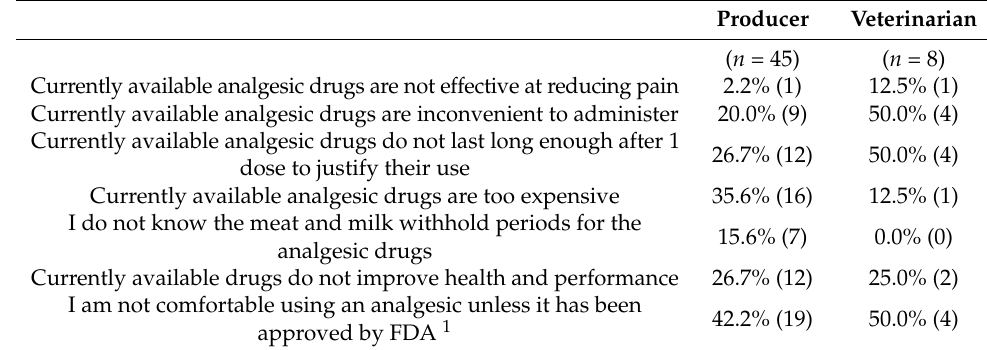
Table 4. Survey respondent ( n = 53) reasons for decreased analgesic use in the last 10 years based on role *.